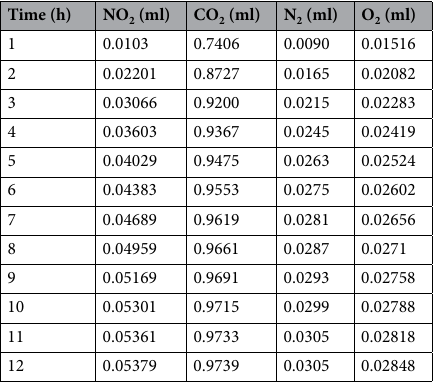
Table 7. Change of accumulated adsorption capacity of 1 g bituminous with time.